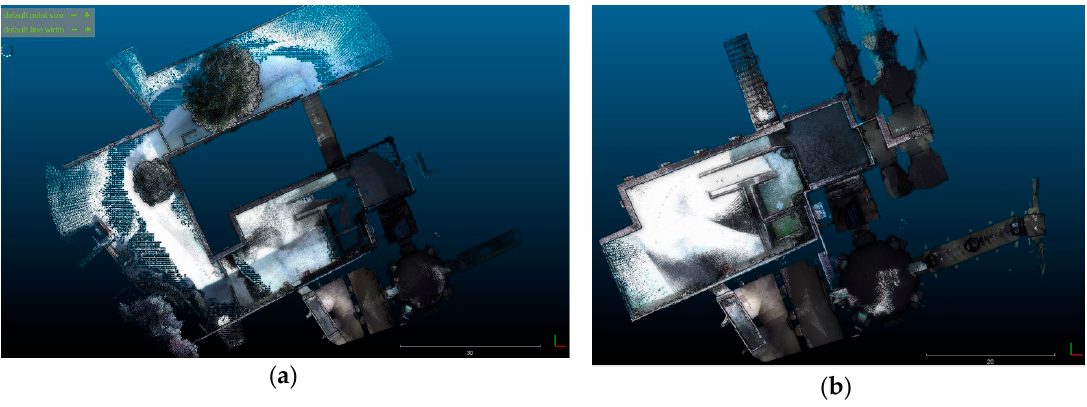
Figure 10. Leica Pegasus Backpack datasets: ( a ) path 1; ( b ) path 2.